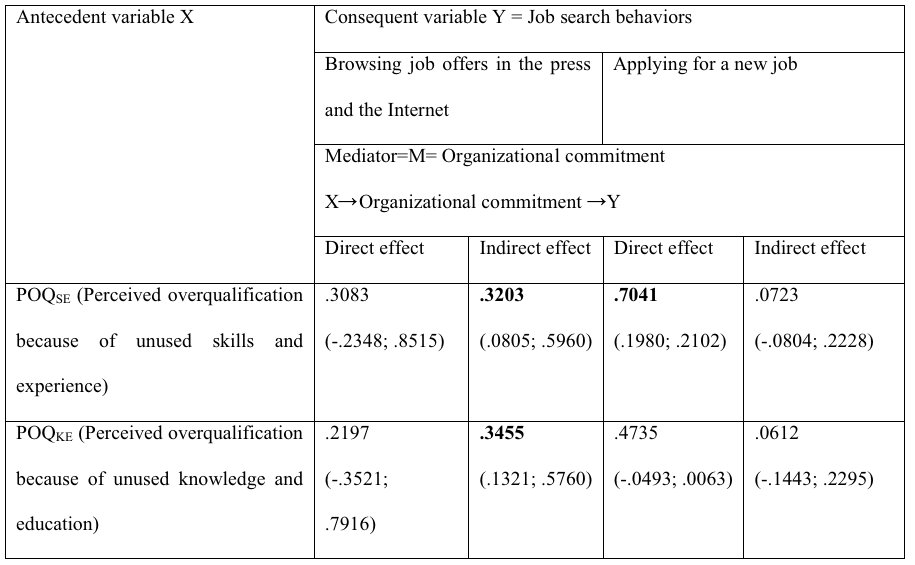
Table 4 Direct and indirect effects of perceived overqualification on job searching behaviors with organizational commitment acting as a